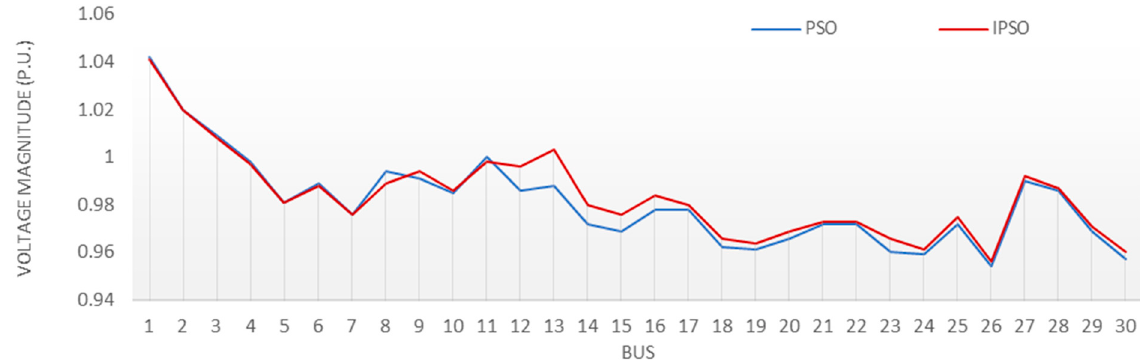
Figure 4. Voltage profile comparison between PSO-OPF and IPSO-OPF.